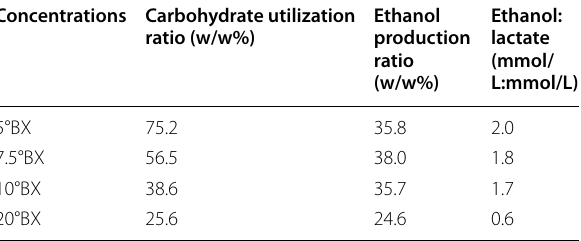
Table 3 Carbohydrate utilization ratio and ethanol